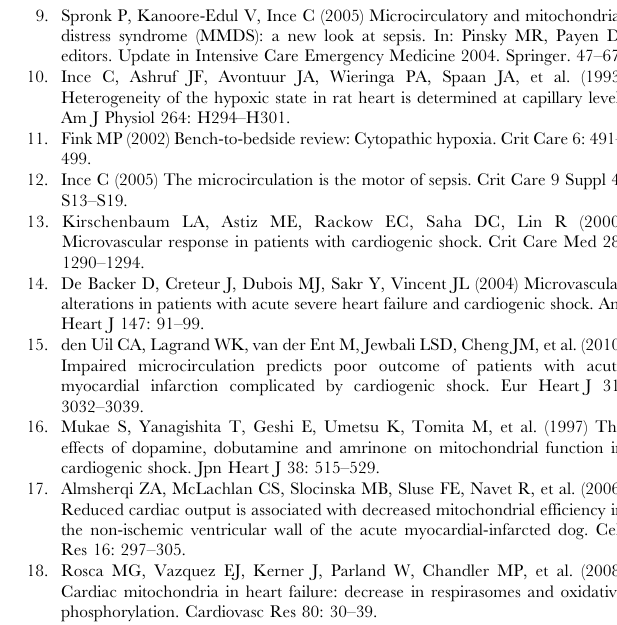
Figure S1 Strain and Strain Rate. A–B: The average radial strain across all regions of interest decreased after coronary microembolization (CME), whereas a similar left ventricular dysfunction was evident by the increase in the average circumferential strain. C–D: The average circumferential strain rate also increased after CME. Data are presented as median 6- range. Open box plots, time-matched control group; filled box plots, cardiogenic shock group. *p , 0.05 within group compared to baseline by one-way repeated measurements analysis of variance. (EPS) Video S1 Example echocardiography recordings. Short- axis transthoracic 2D images from a cardiogenic shock animal at baseline, after coronary microembolization and during cardiogen- ic shock. (M4V) Video S2 Example microcirculatory recordings. Side- stream darkfield images from a pilot experiment at baseline, during cardiogenic shock and after the administration of high-dose arginine-vasopressin.